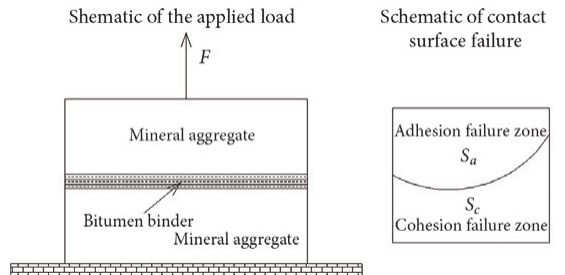
Figure 1. Schematic of the tension failure test of the mineral aggregate contact surface